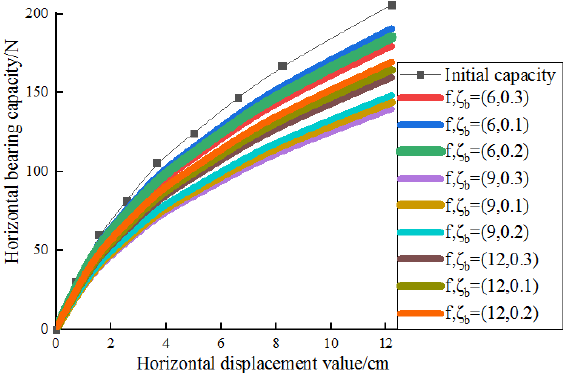
Figure 11. Degradation of static horizontal capacity.